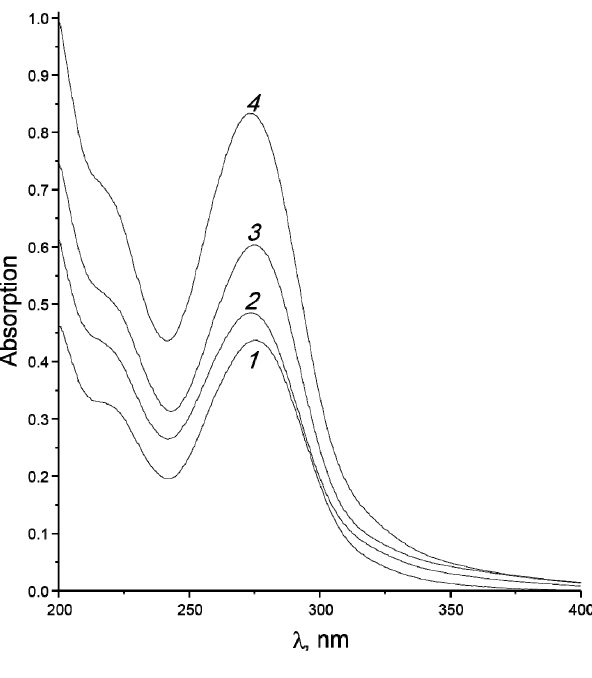
Figure 11. UV spectra of condensates obtained from cellulose C2 samples with specific surface areas of 49 ( 1 ), 70 ( 2 ), 104 cm 2 /g ( 3 ) at starting temperature of 16 °C, and also for a sample with Z = 104 cm 2 /g ( 4 ) at 230 °C